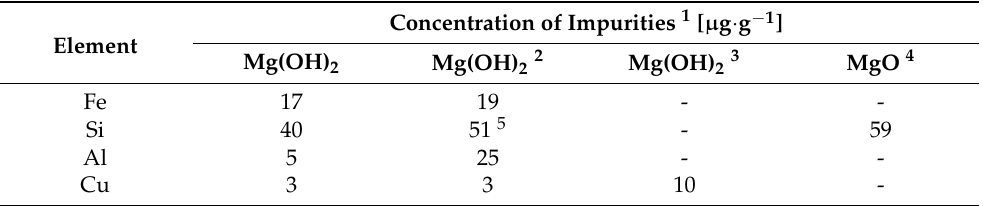
Table 10. Determination of concentration of Fe, Si, Al and Cu in Mg(OH) 2 and MgO (batch III fraction III) after formation of the grains of the hydroxide and subsequent thermal decomposition into